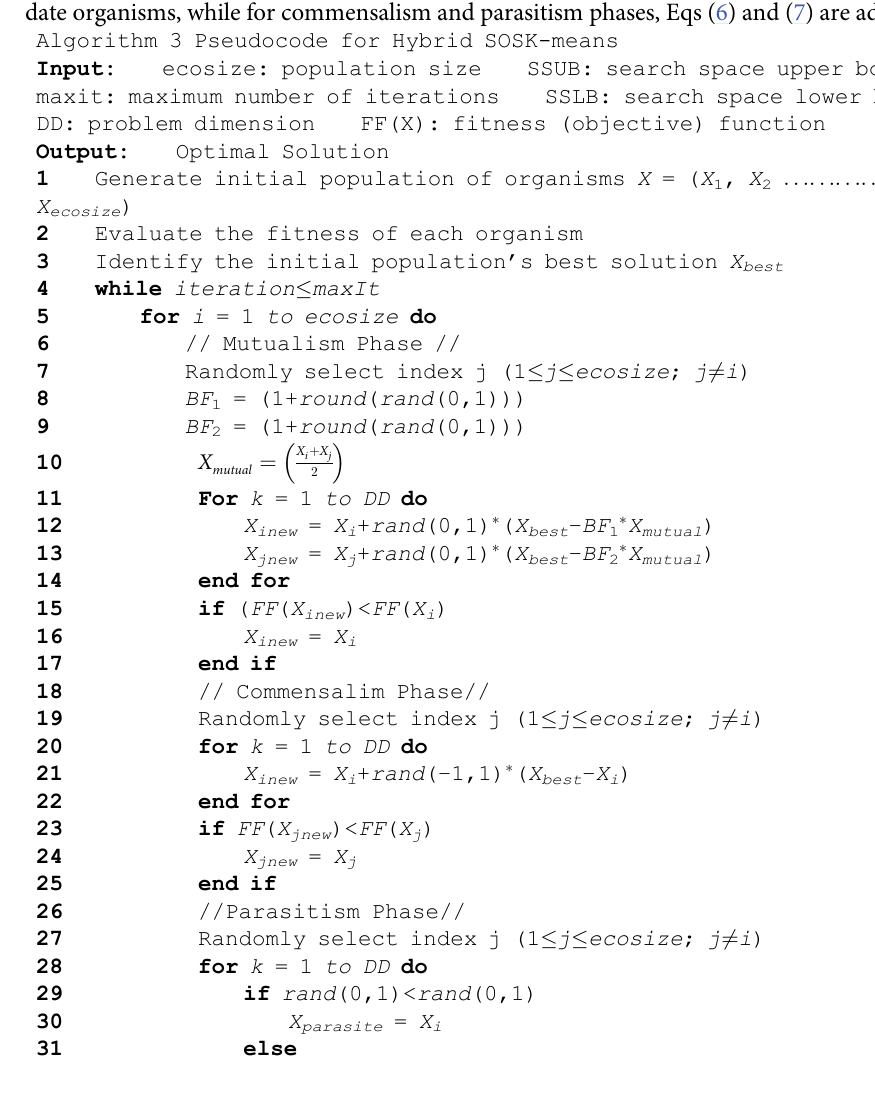
Algorithm 3 Pseudocode for Hybrid